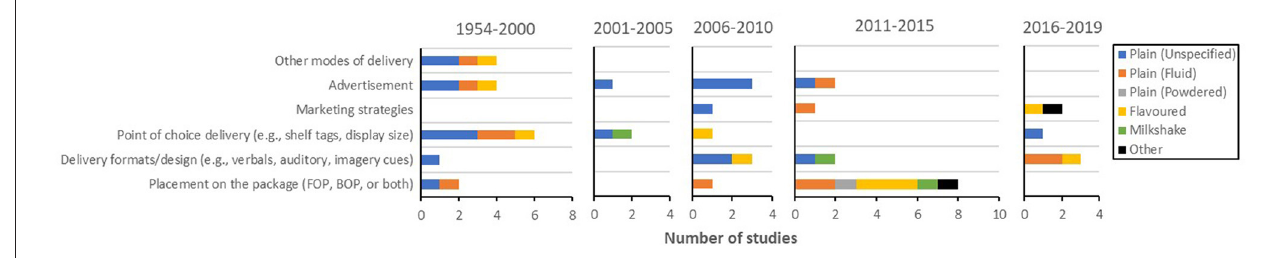
FIGURE 12 | Prevalence of medium-related empirical studies for each milk type [i.e., plain (unspecified), plain (fluid), plain (powdered), flavoured milk, milkshake, and other milk drinks] during each period (i.e., 1954–2000, 2001–2005, 2006–2010, 2011–2015, and 2016–2019). FOP, front-of-pack; BOP,